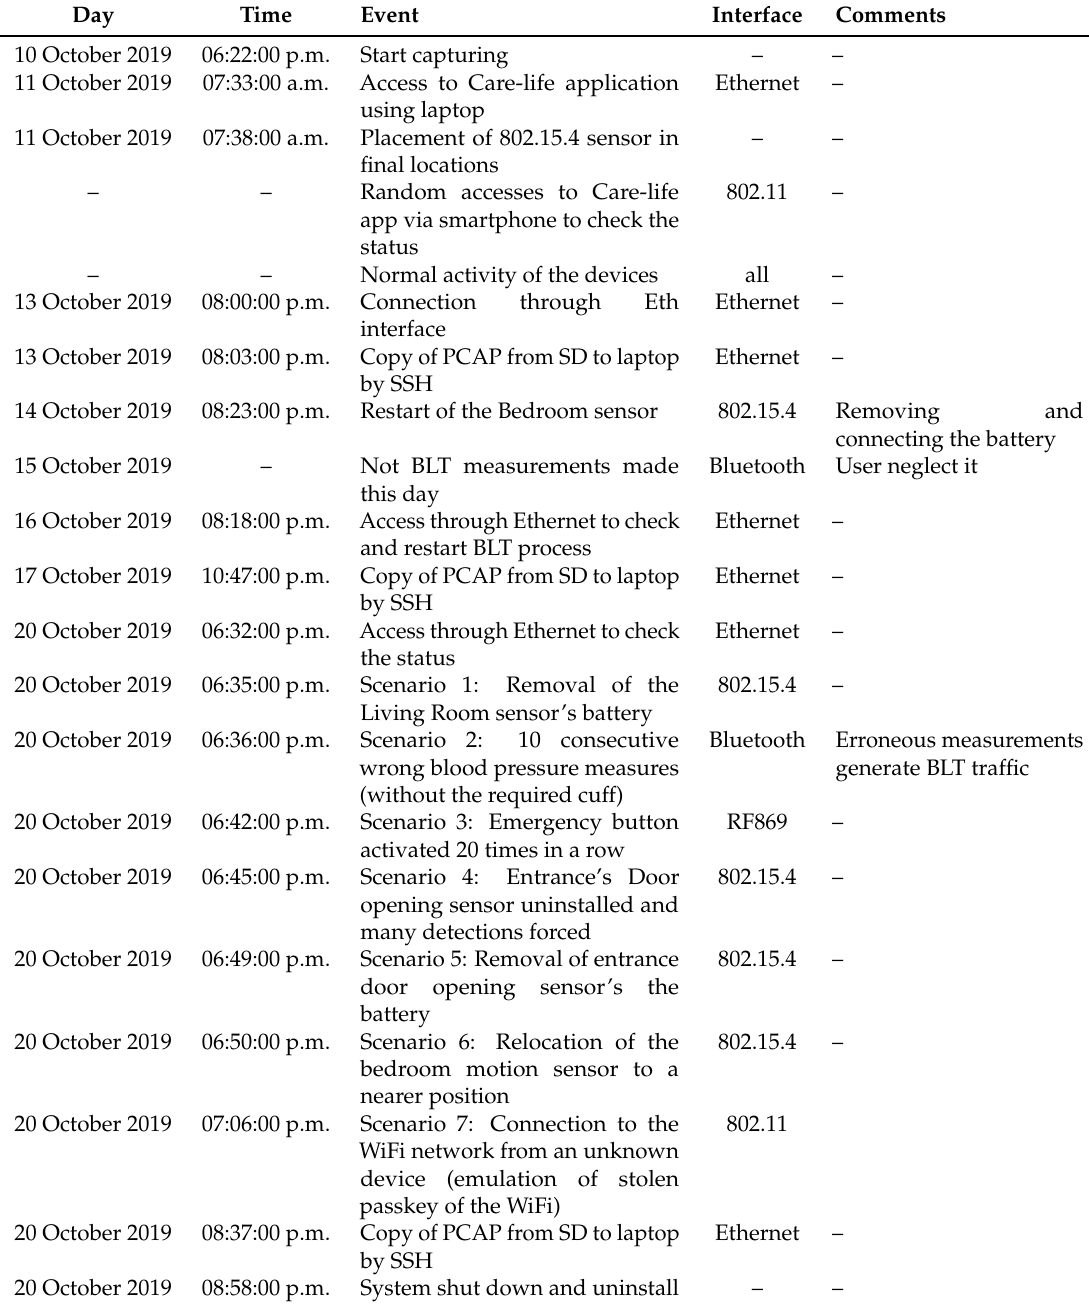
Table 2. Events during capture